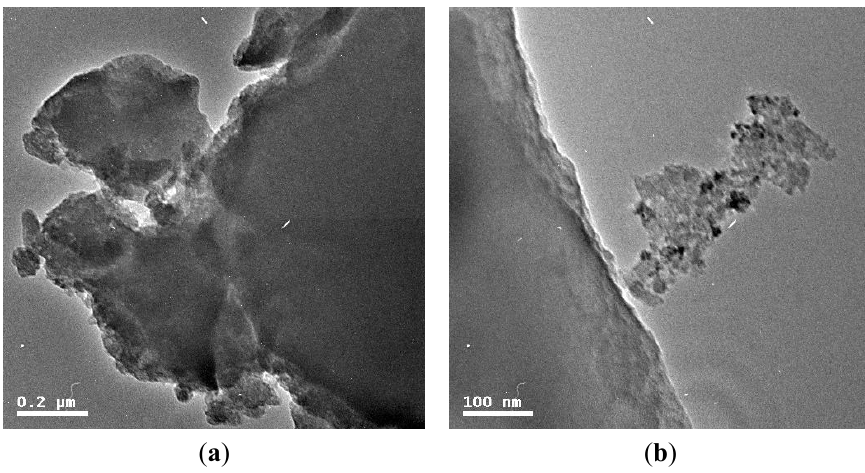
Figure 6. Transmission electron microscopy (TEM) analysis of the selected catalyst: ( a ) AC; ( b ) 7% Mn-Ce/AC (Mn/Ce 1:4).